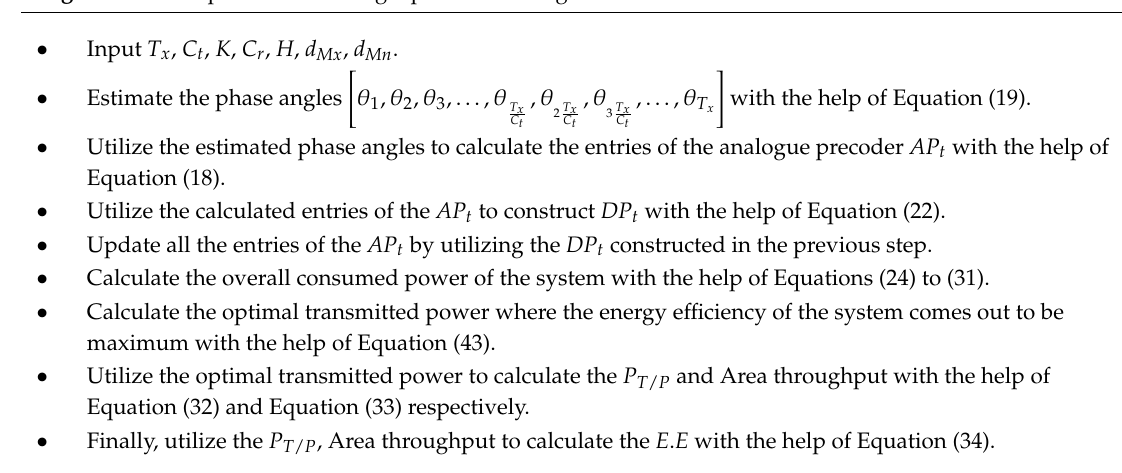
Algorithm 1. Proposed Alternating Optimization